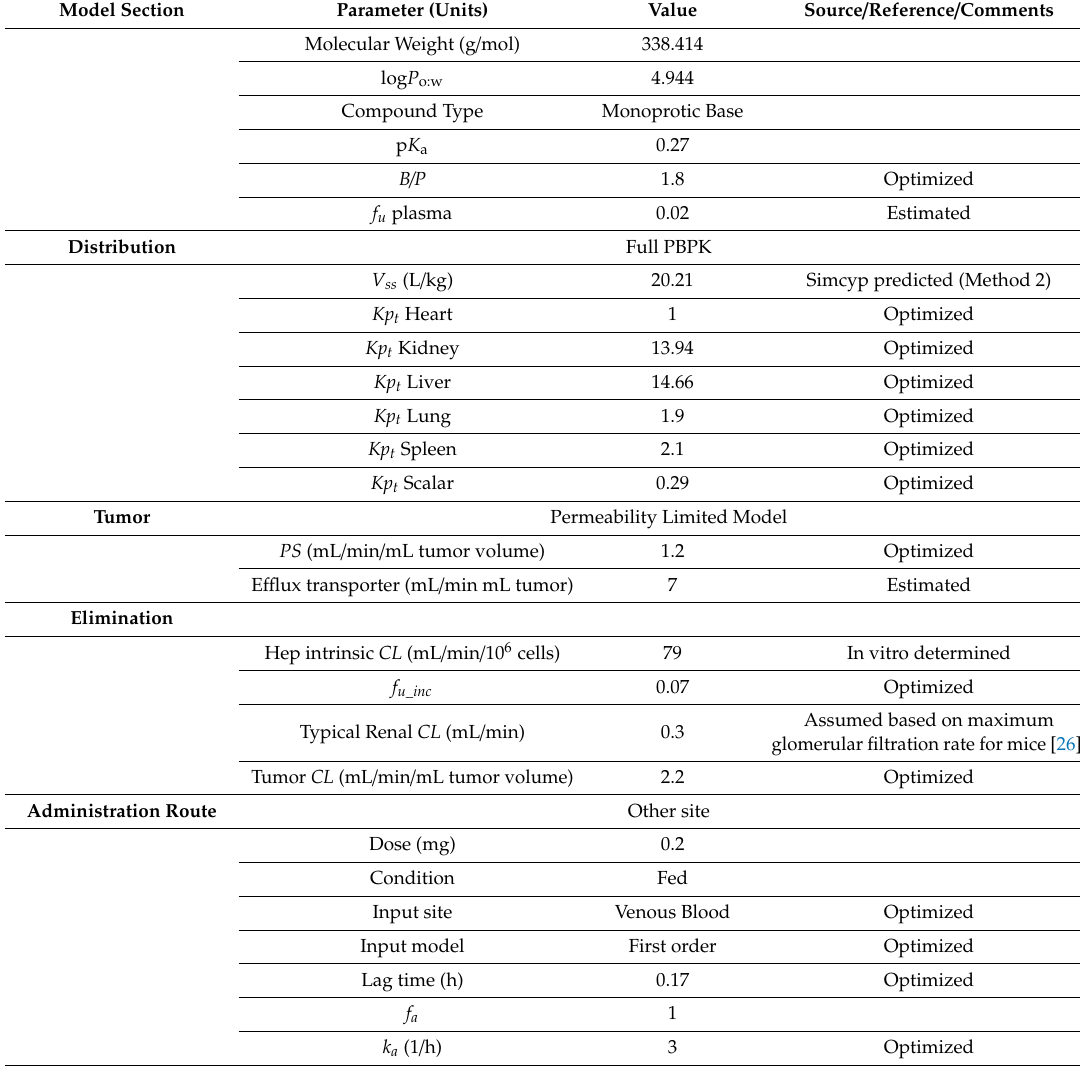
Table 1. Parameters of the PBPK model for